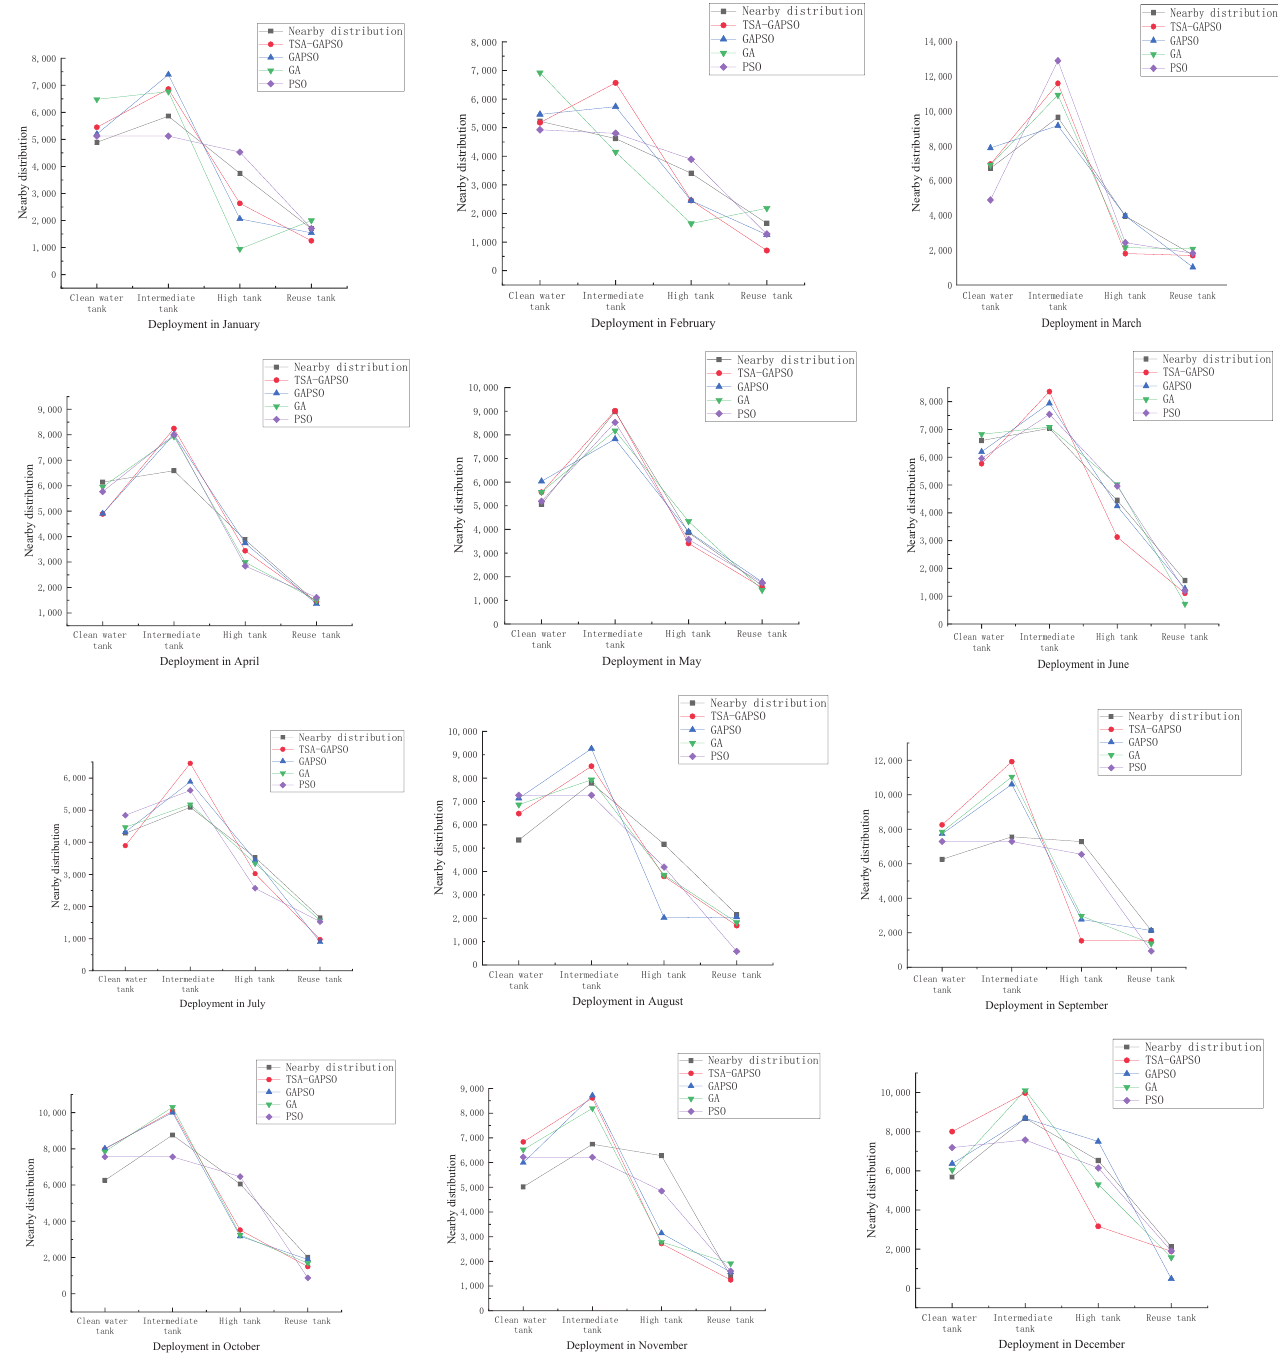
Figure 8. Mine water and moon dispatching